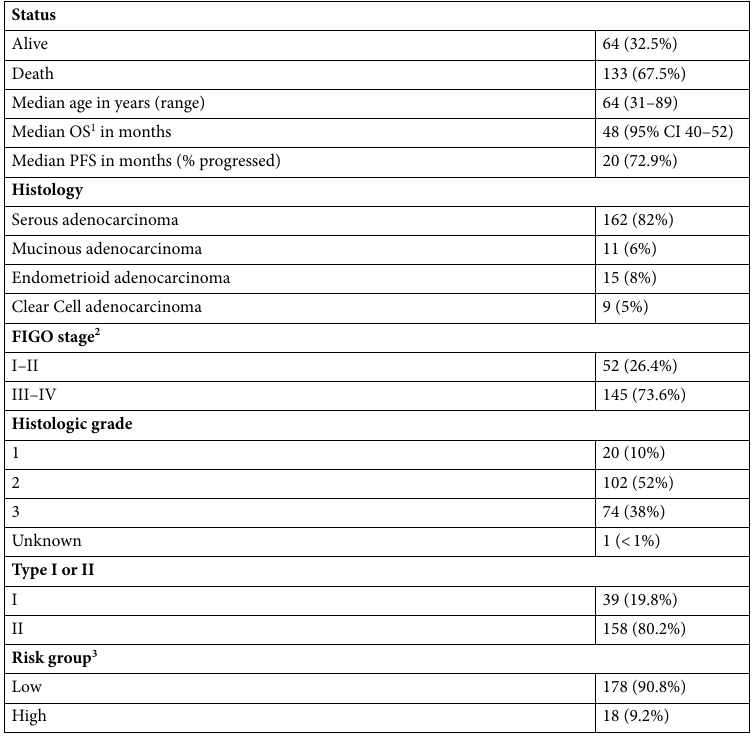
Table 1. Clinicopathological characteristics of OC patients. 1 OS = overall survival. 2 FIGO = International Federation of Gynaecology and Obstetrics. 3 Risk group is based on the 4 found